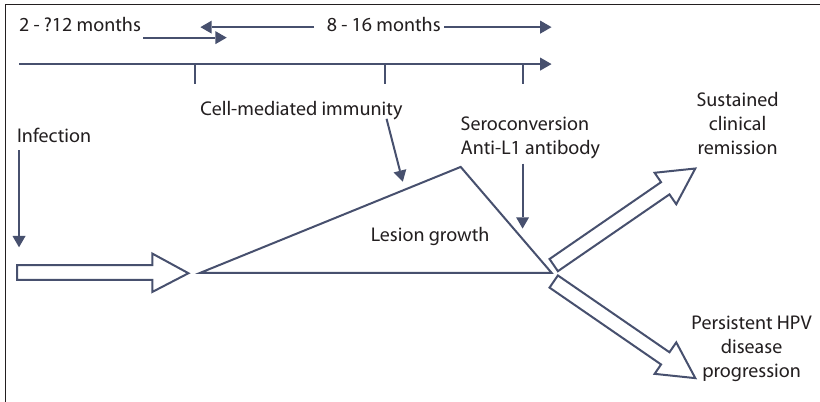
Fig. 1. Natural course of genital HR-HPV infection (source: Stanley [82]